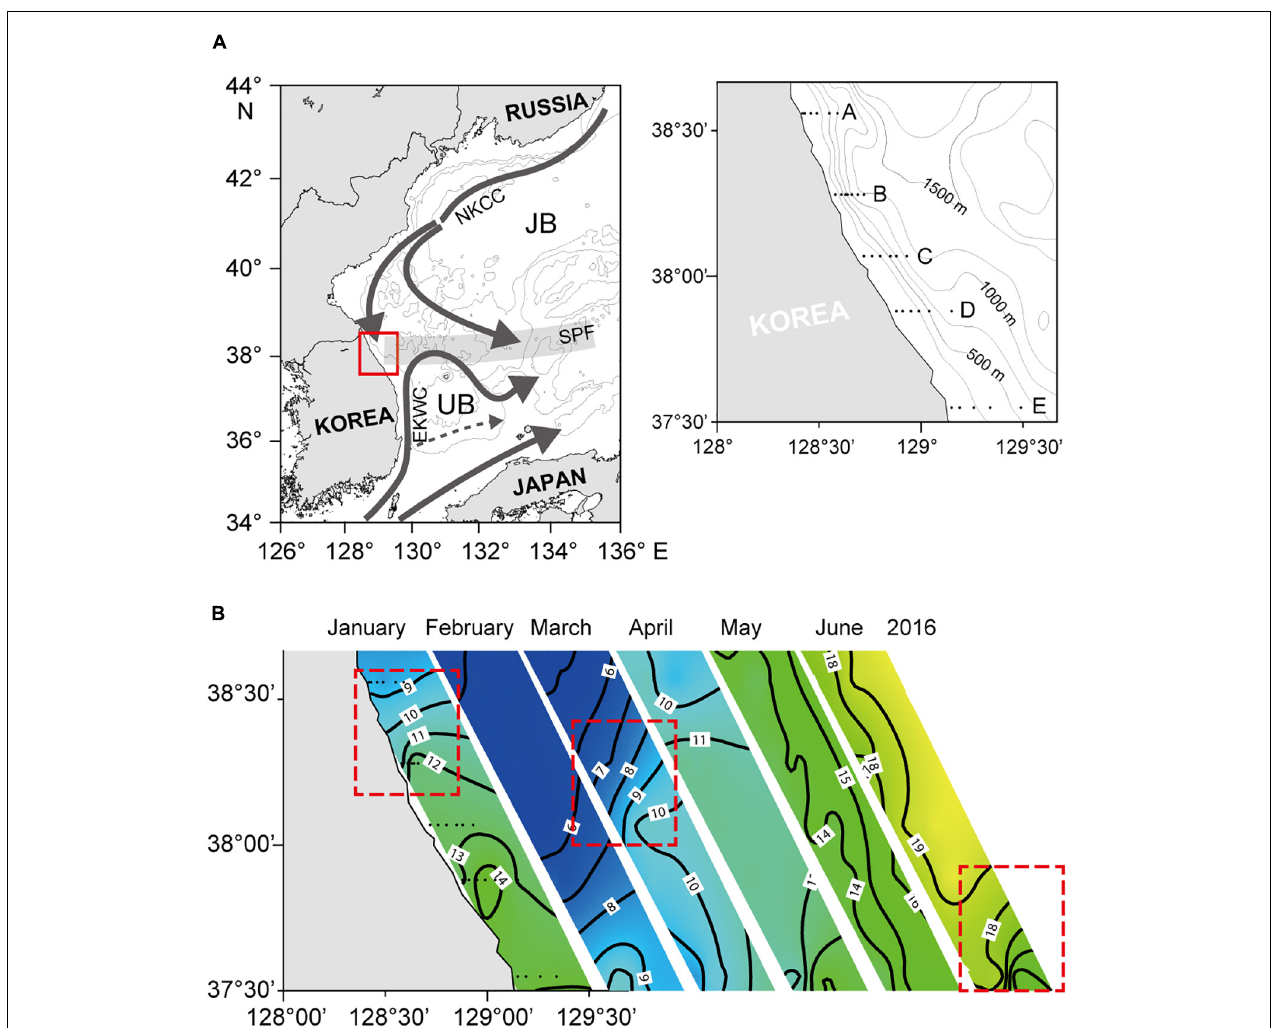
FIGURE 1 | Map showing the study area in the East/Japan Sea. (A) Sampling location marked by the red square (left) and five observation transects (right). NKCC, North Korean Cold Current; EKWC, East Korean Warm Current; SPF, Subpolar front; JB, Japan Basin; UB, Ulleung Basin. (B) Horizontal distribution of sea surface temperature (SST) during winter–summer 2016. A sharp longitudinal SST gradient indicates that SPFs were formed in January–March 2016. Areas enclosed in the red-dotted lines represent the locations of